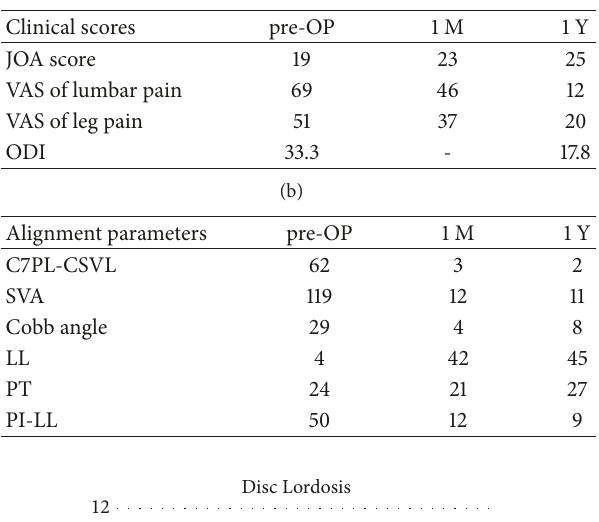
Table 3: Clinical scores and alignment parameters of case no. 21.